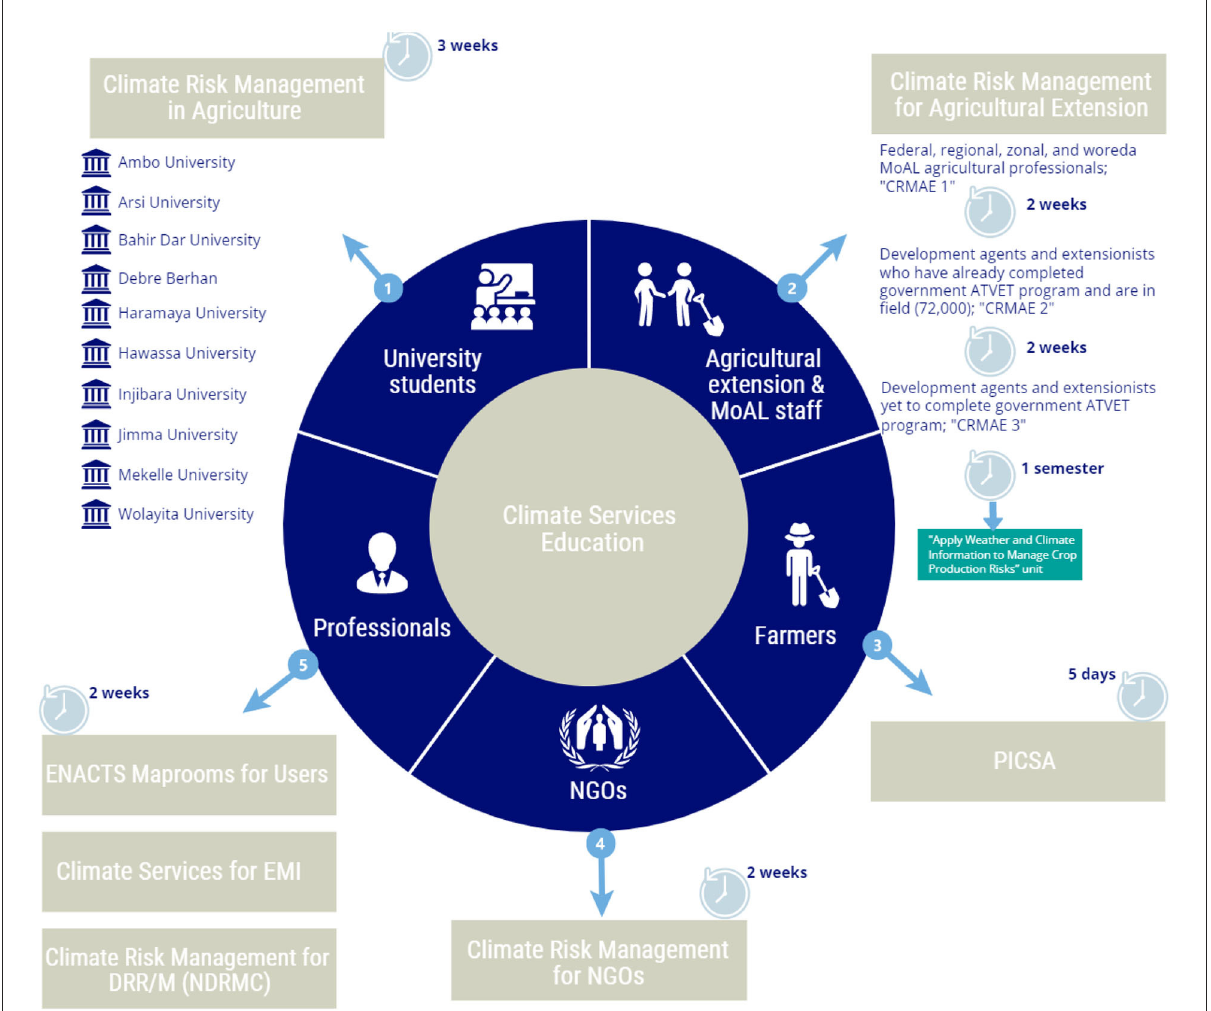
FIGURE5 Groups targeted with foundational capacity building and curricula on climate risk management in Ethiopia. Each brown box represents a different curriculum or training package developed through the ACToday approach on climate risk management, while clocks represent the recommended implementation time for each